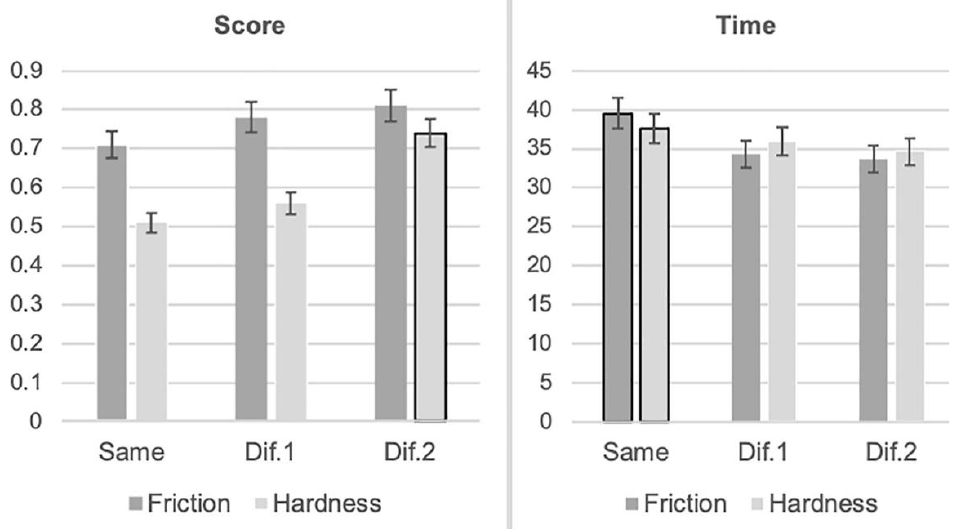
Figure 4. Participants’ score and completion time for those surfaces that had the same value of friction or hardness or surfaces that differed from each other slightly (Dif.1) or a lot (Dif.2) in terms of the value of friction or hardness. The significant differences are highlighted with a black border.